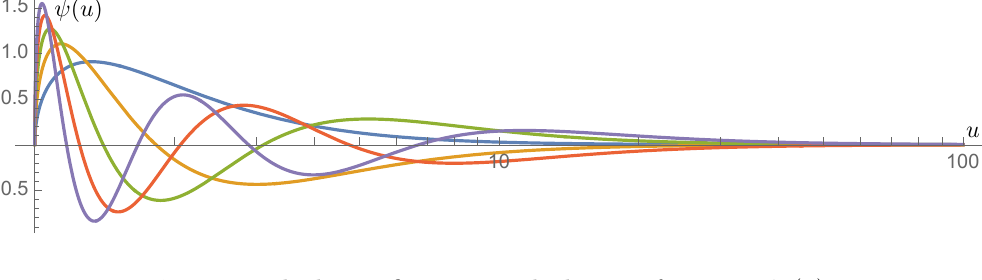
Figure 1 . The lowest five unperturbed vector functions ψ n ( u ) .